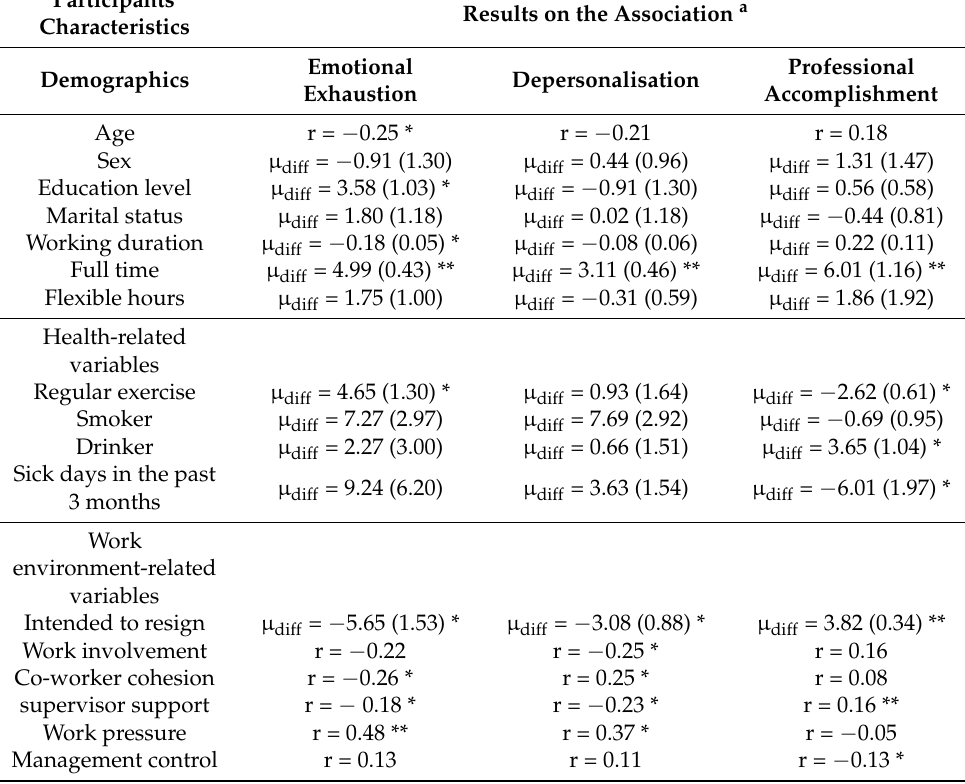
Table 2. Correlation or mean difference (s.e.) and unadjusted associations between demographic, health-related, work environment-related variables, and burnout. Participants’ Results on the Association a Characteristics Demographics Depersonalisation